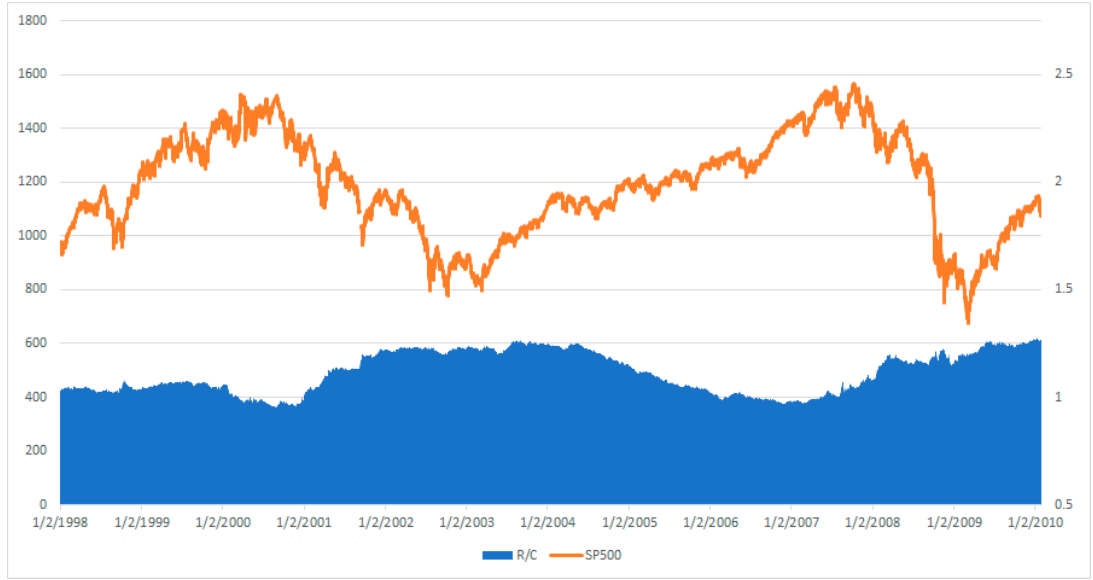
Figure 2. R/C vs